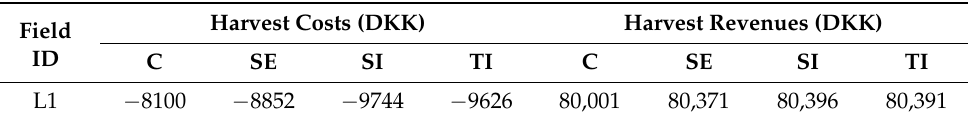
Table 3. Detailed calculations of harvest costs and revenues in DKK of field L1 for the four harvesting cases.